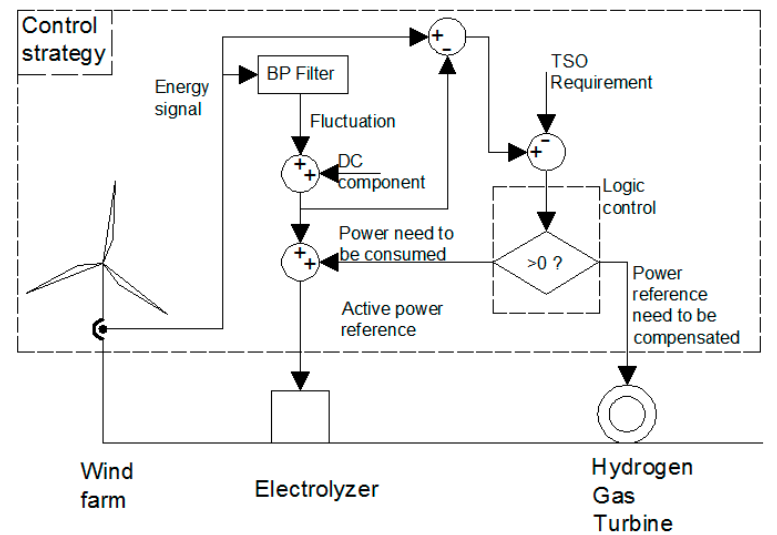
Figure 2. Control strategy diagram.